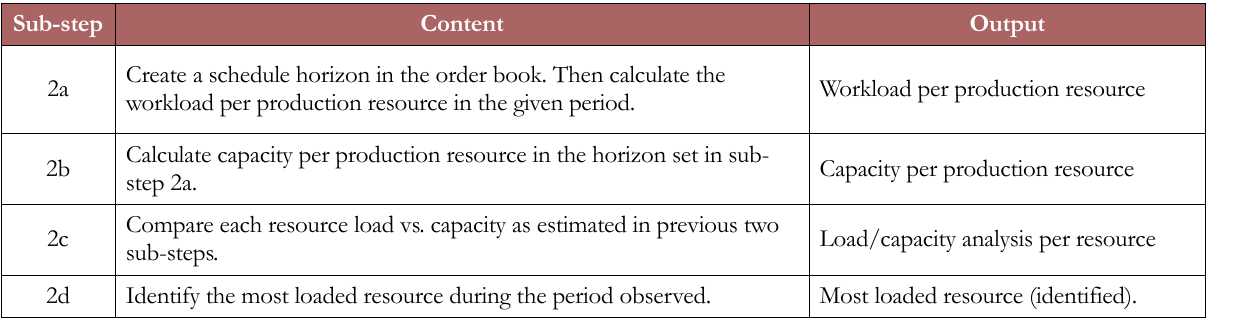
Table 5. Load versus capacity